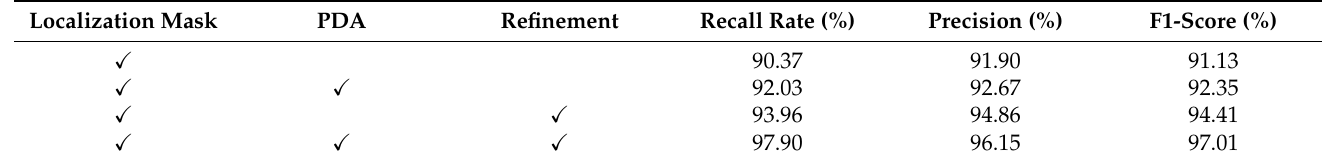
Table 2. Ablation study for demonstrating the effectivness of PDA module and refinement network. Localization Mask PDA